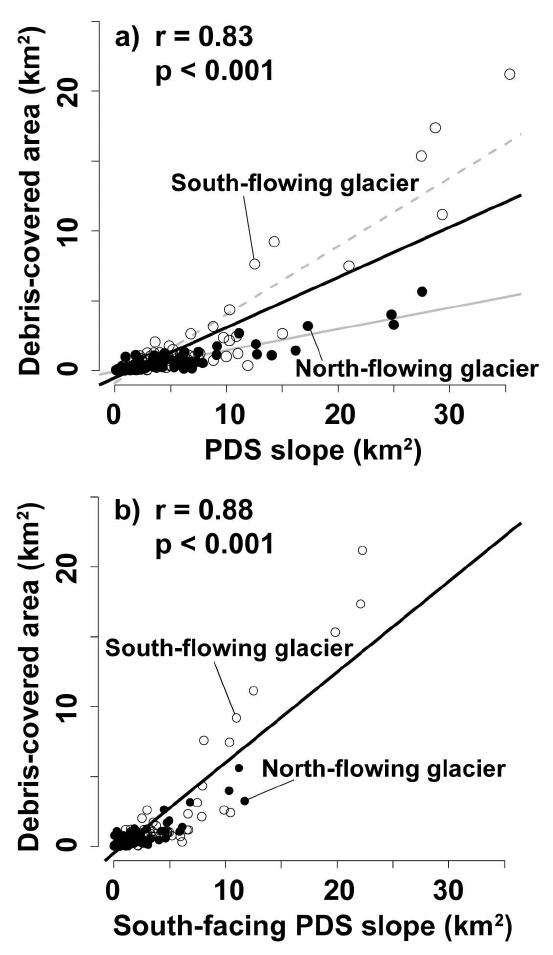
Fig. 5. Debris-covered area plotted against potential debris-supply (PDS) slope area of (a) all aspects, and (b) south-facing aspects (90–270 ◦ clockwise from north), for debris-covered glaciers in the Bhutan Himalaya. Grey solid ( y = 0 . 15 x − 0 . 06, R 2 = 0 . 82) and dashed lines ( y = 0 . 49 x − 0 . 85, R 2 = 0 . 84) denote linear regres- sions for the north-flowing ( r =0.90, p < 0 . 001) and south-flowing ( r =0.92, p < 0 . 001) glaciers, respectively. Correlation coefficient and linear regression for (a) all aspect PDS slopes ( r =0.83, p < 0 . 001, y = 0 . 36 x − 0 . 56, R 2 = 0 . 69) are improved in (b) south- facing PDS slopes ( r =0.88, p < 0 . 001, y = 0 . 65 x − 0 . 55, R 2 = 0 .